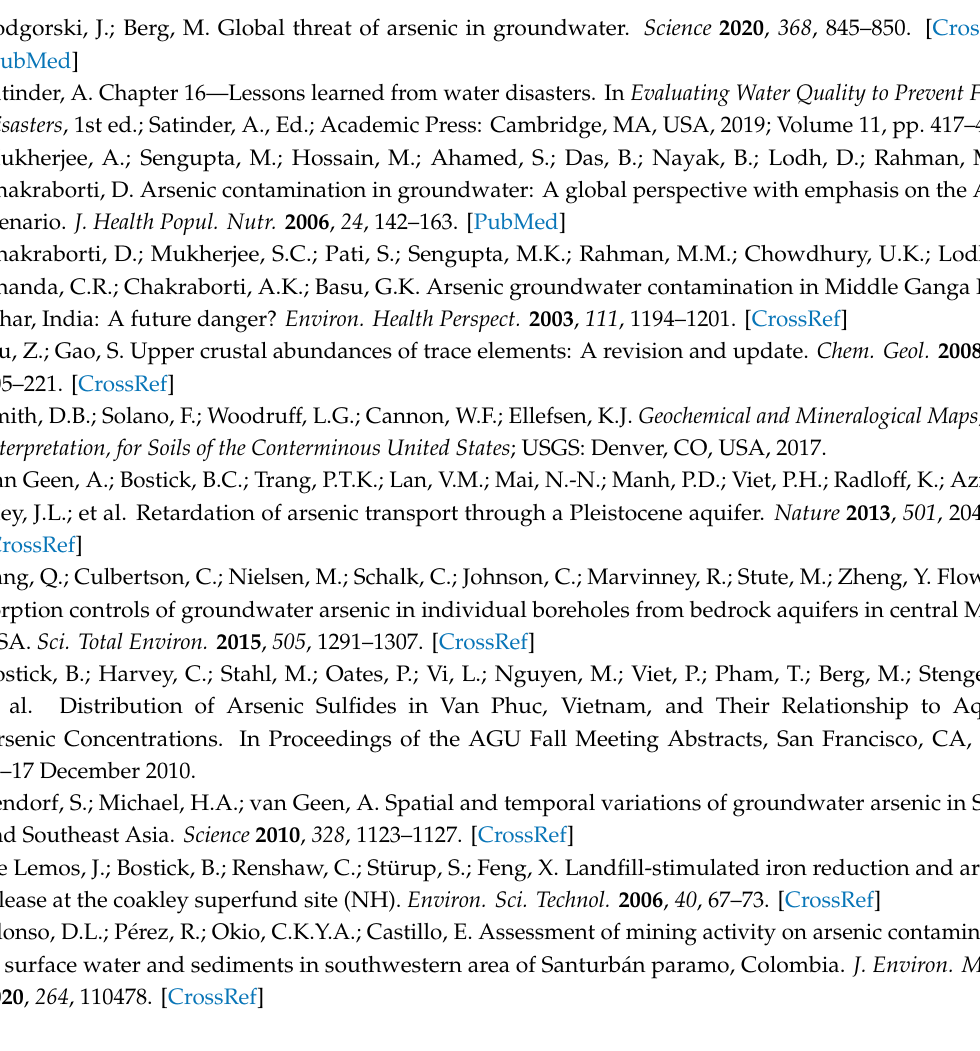
Figure S1: Simplified stratigraphic logs of the three monitoring wells drilled in 2018, Table S1: Sediments sampling elevation collected in 2018 sampling survey, CMT elevation levels and groundwater sampling elevation and As content in sediment and groundwater, Table S2a: Pearson correlation matrix for MW07-ML, Table S2b: Pearson correlation matrix for MW08-ML, Table S2c: Pearson correlation matrix for MW09-ML, Table S3: Sequential extraction results from 2016 sampling